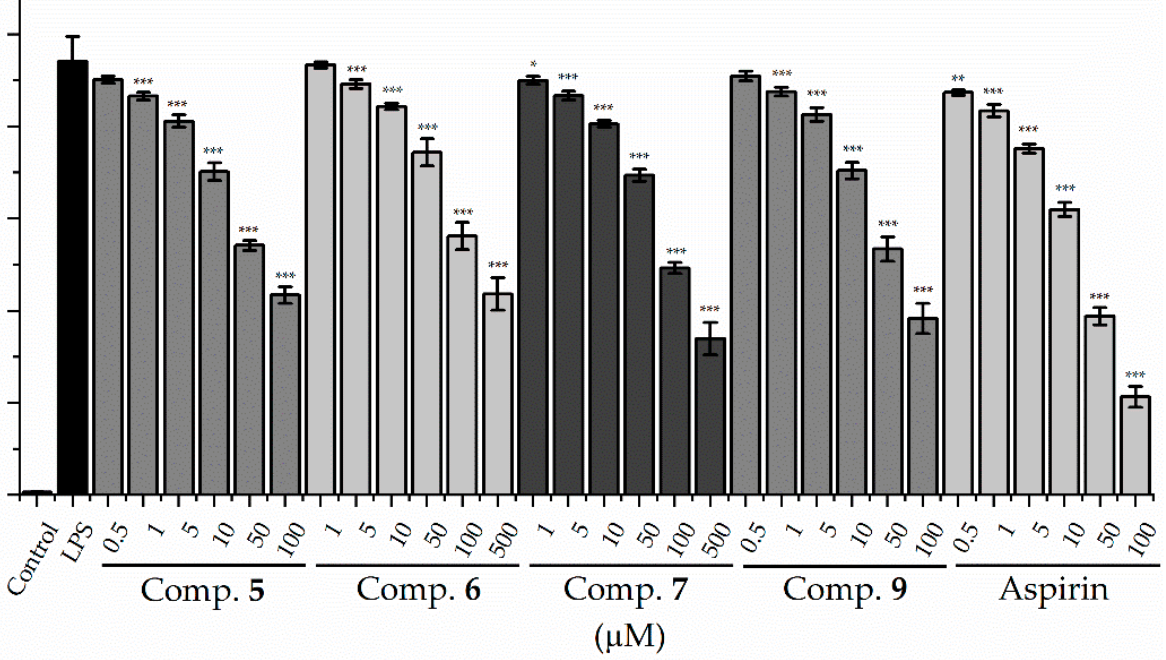
( A ) ( B ) Figure 5. Effects of compounds 5 and 9 on IL-6 ( A ) and NO ( B ) production in LPS-stimulated raw 264.7 cells. ** p < 0.01, and *** p < 0.001 compared with LPS-stimulated group. Aspirin (positive control). Table 2. IC 50 values a ( μ M) of compounds 5 – 7 and 9 as inhibitors of TNF- α , IL-6 and NO. Compounds